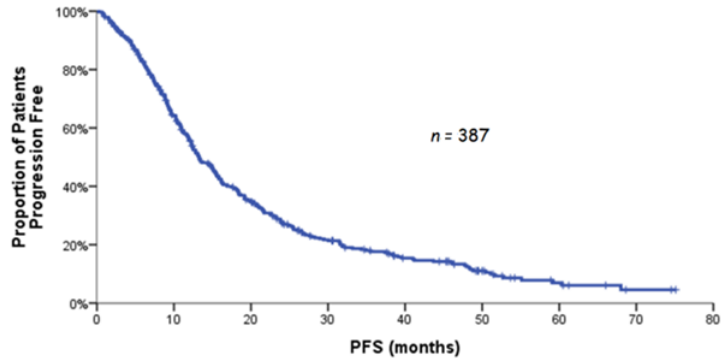
Figure 1. Kaplan – Meier curve for PFS. Figure 1. Kaplan–Meier curve for PFS.